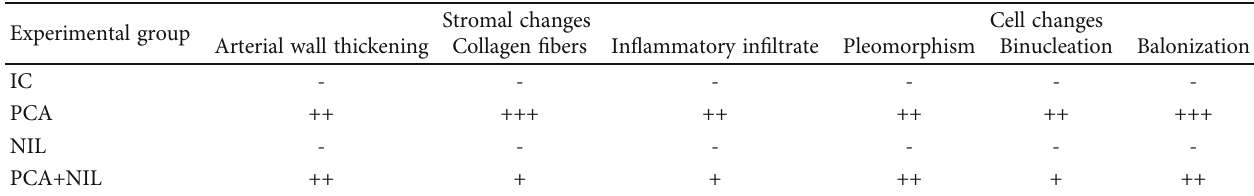
Figure 6: E ff ects of neurointermediate pituitary lobectomy (NIL), portacaval anastomosis (PCA), and PCA+NIL on the relative expression of (a) collagen type 1 (COLI), (b) metalloproteinase-9 (MMP-9), and (c) metalloproteinase-13 (MMP-13). (a) ∗ p < 0 : 05 : IC vs. PCA-NIL and ∗∗ p < 0 : 01 : IC vs. PCA. (b) Nonstatistical di ff erences between groups were apparent. (c) ∗∗ p < 0 : 01 : IC vs. NIL, ∗∗ p < 0 : 01 : IC vs. PCA+NIL, and ∗ p < 0 : 05 : NIL vs. PCA. The intact control (IC) group served as reference. It was evaluated with analysis of variance test with the Kruskal-Wallis test and Dunn ’ s post hoc values, which are expressed as the mean ± SD . Table 2: Table of parameters of magnitude of cell damage and